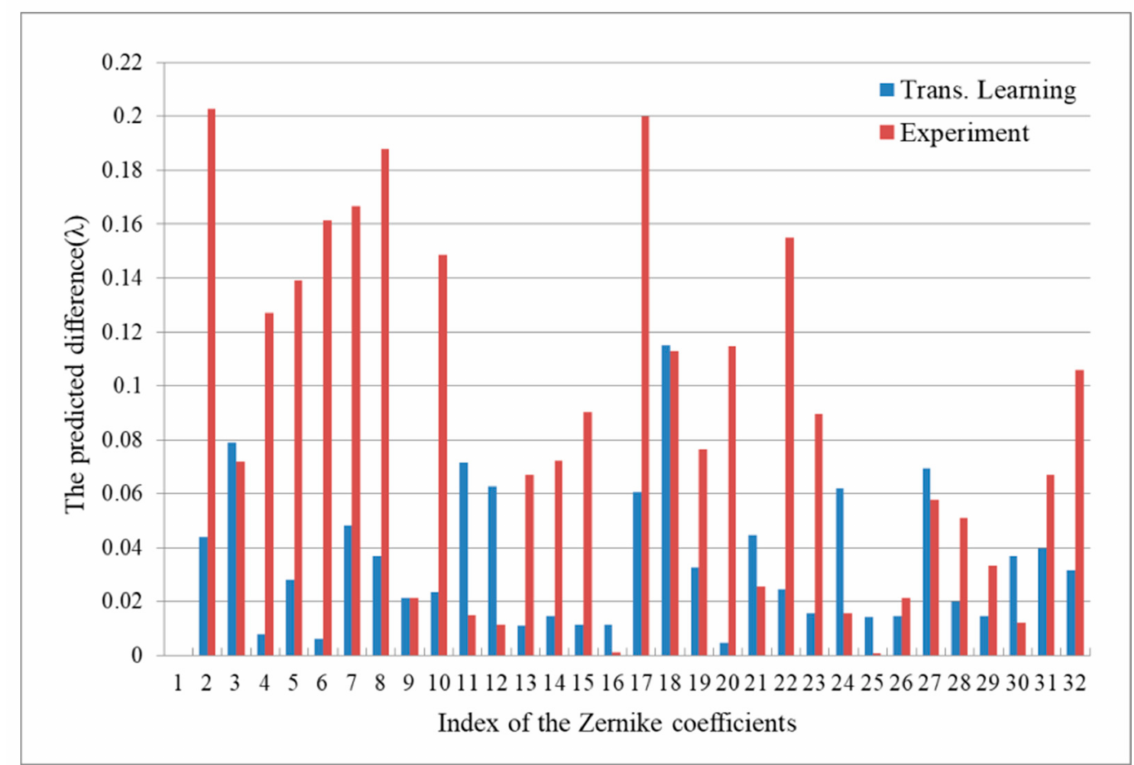
Figure 10. The Zernike coefficients and predicted values with or without transfer